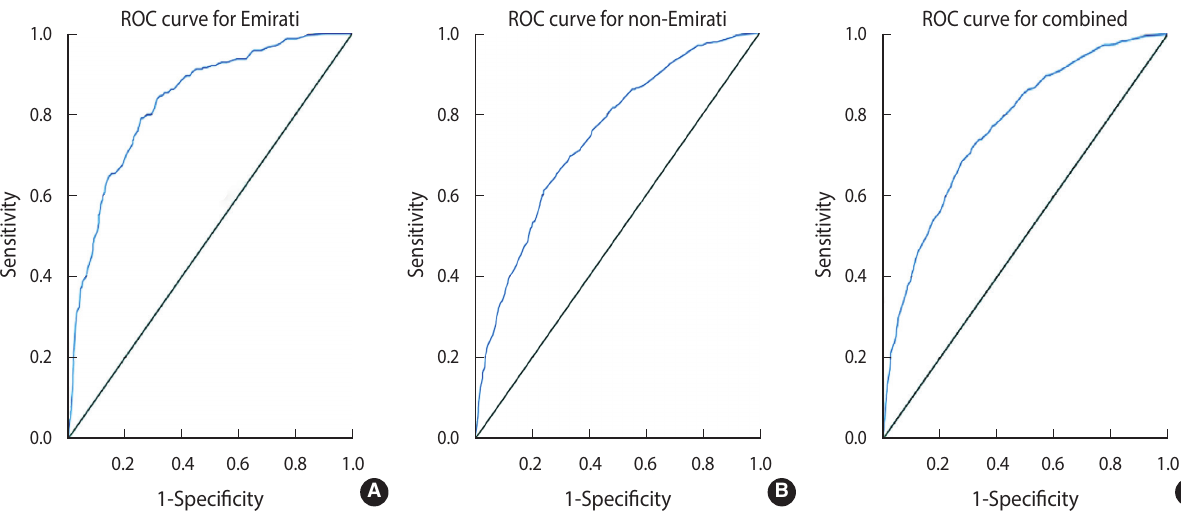
Figure 2. Receiver-operating characteristic (ROC) curves demonstrating the hypertension risk score model’s performance in predicting hypertension (A) Emirati, (B) non-Emirati, and